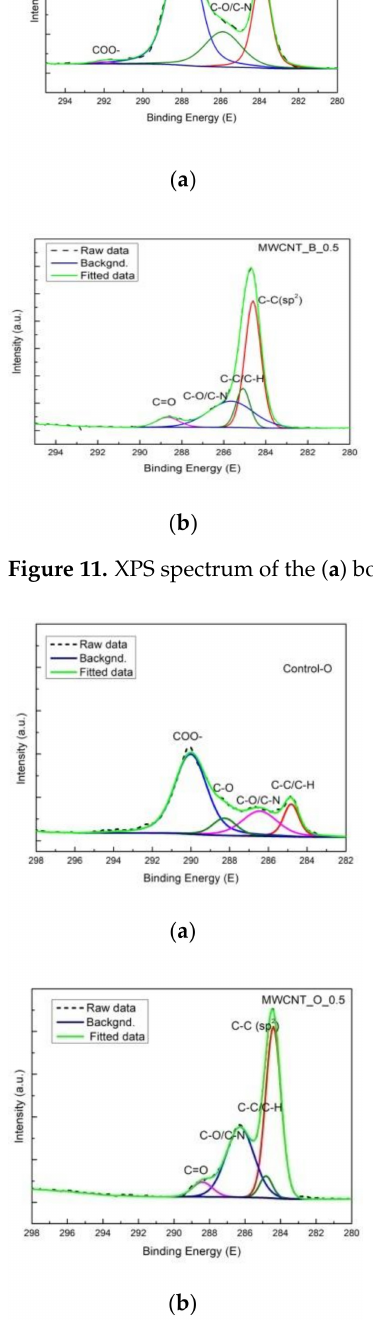
Figure 12. XPS spectrum of the ( a ) sheepskin control leather surface and ( b )